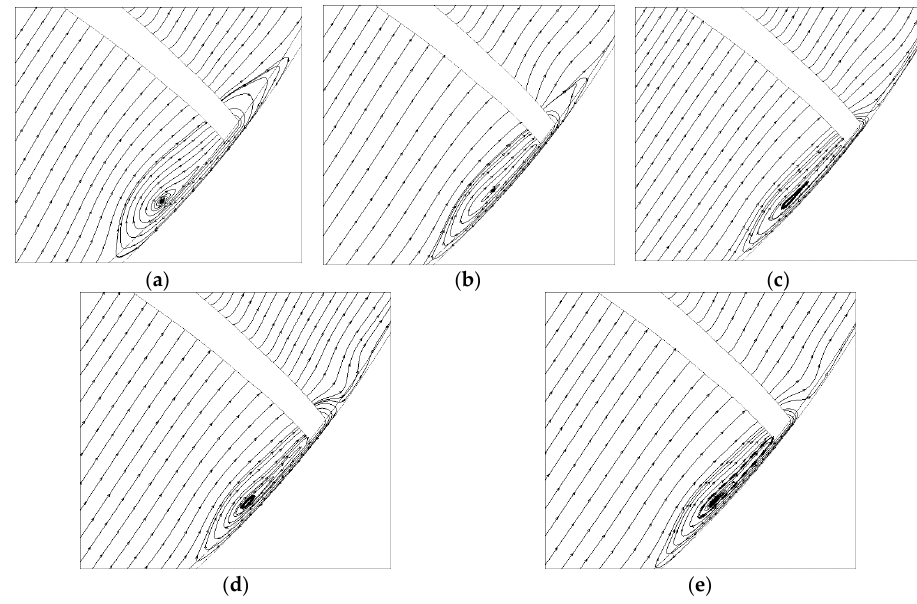
Figure 14. Streamline near blade end for unsymmetrical tip clearance: ( a ) Blade B; ( b ) Blade A1; ( c ) Blade A2; ( d ) Blade A3 and ( e ) Blade